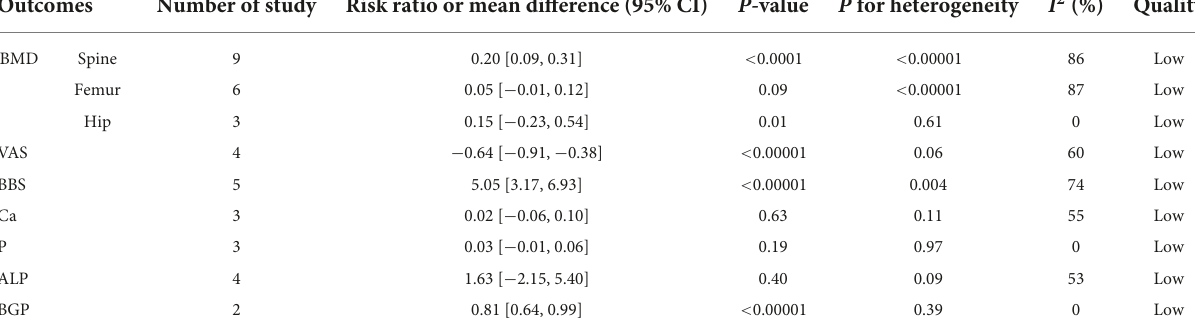
TABLE 2 The results of all outcomes: all participants. Outcomes Number of